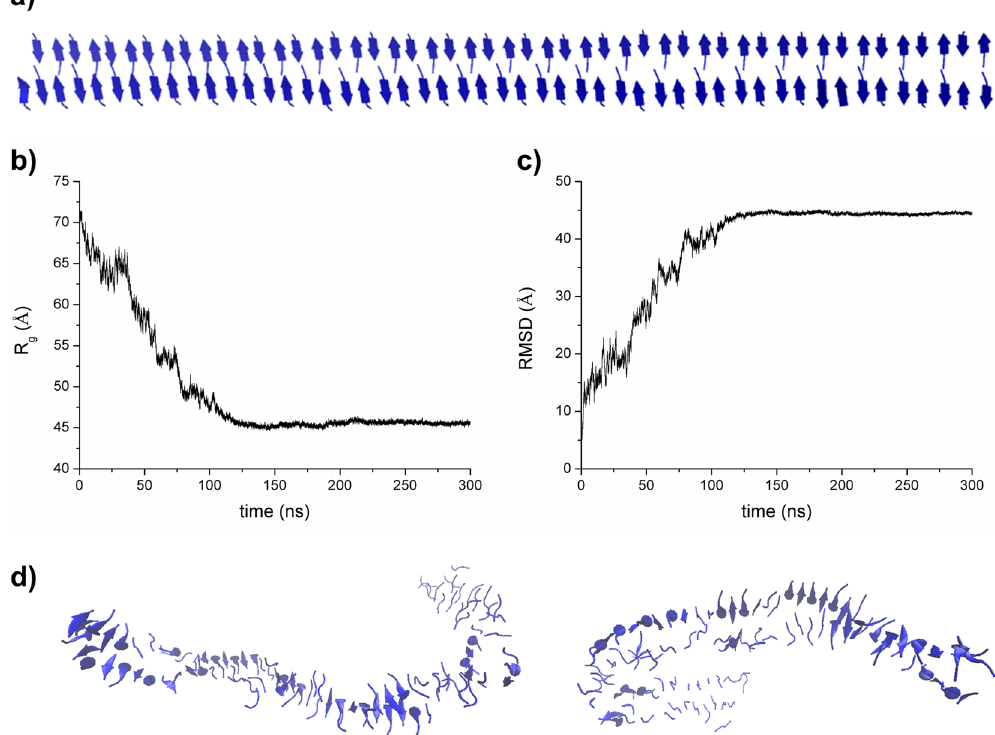
Figure 3. MD simulation of Y4_ST50_SH2. The starting model is reported in panel ( a ). The gyration radius and the RMSD values of the trajectory structures versus the starting flat model are reported in panels ( b ) and ( c ), respectively. Representative examples of trajectory structures are reported in panel ( d